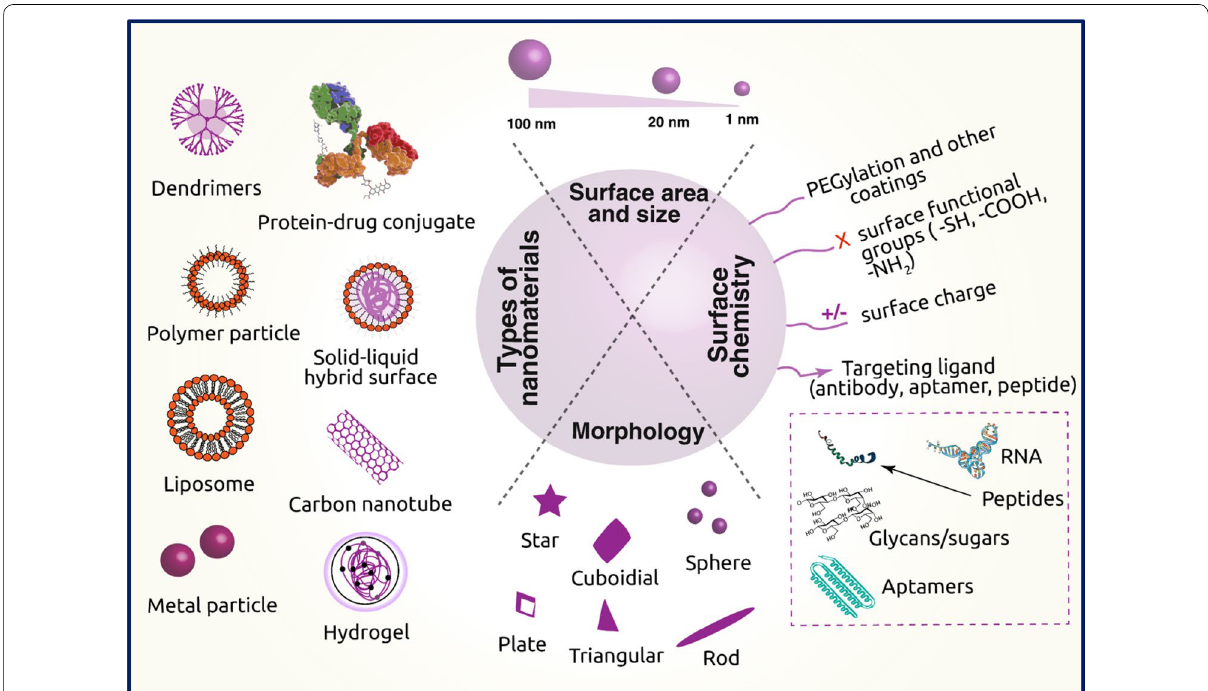
Fig. 1 Schematic representation of different types of nanomaterials employed in cancer therapy, their important physical properties and surface chemistry required to carry